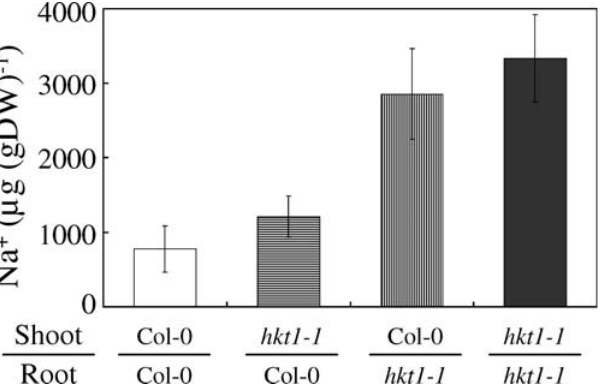
Figure 6. Root At HKT1 Expression Is Determinant for Shoot Na þ